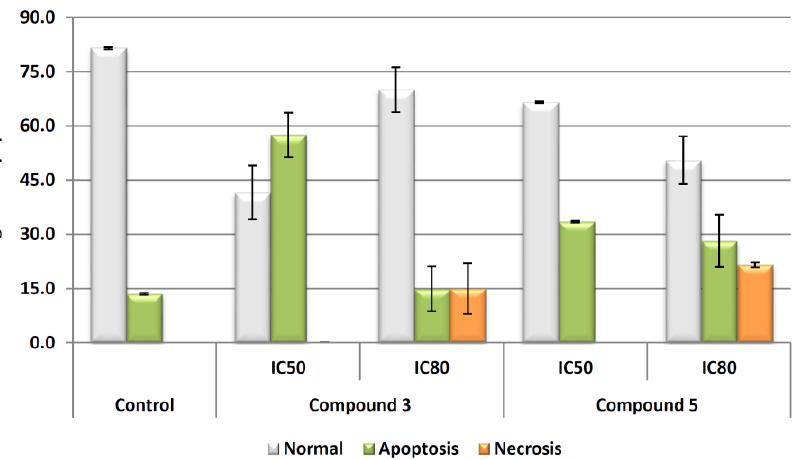
Figure 2. Flow cytometry results after exposure of Hep-G2 cells to DCF and the derivatives 4 and 8c for 72 h at IC 50 and IC 80 concentrations. Apoptotic cells (green bars) were positive in annexin V, necrotic cells (orange bars) were positive in propidium iodide. Values are expressed as means ± S.E.M. of at least two experiments in duplicate.